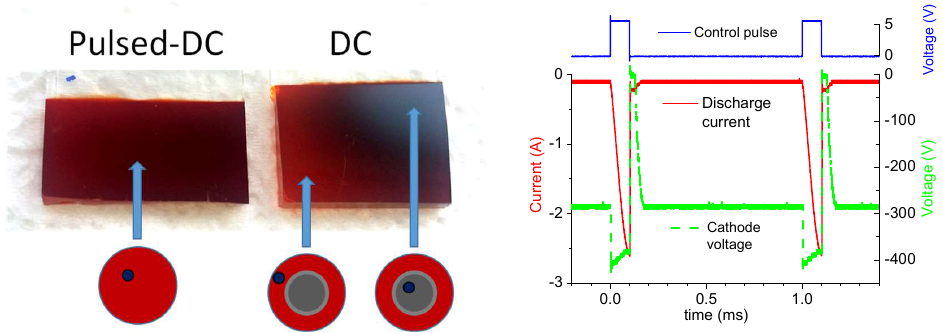
positions of the color-coded regions on the deposited films are indicated by blue arrows. The real color of the obtained samples was similar to that of natural minerals, i.e., it varied between black, yellow, red and brown.